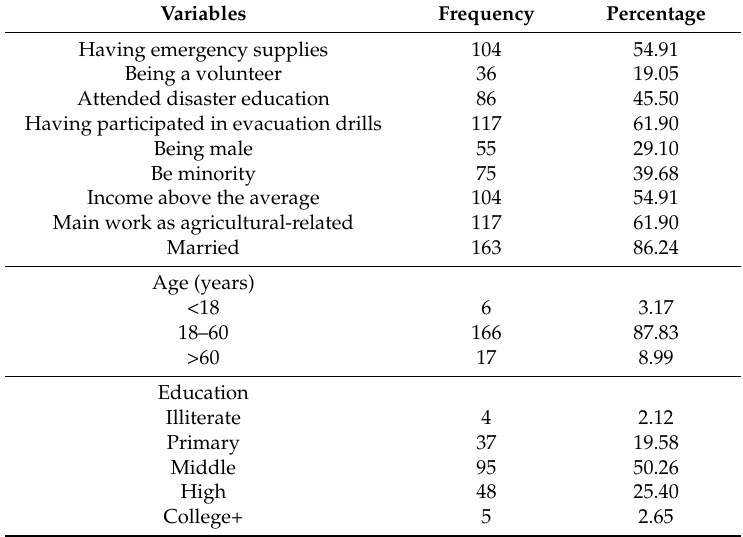
Table 1. Descriptive analysis of disaster risk reduction activities and socio-demographic characteristics (N =